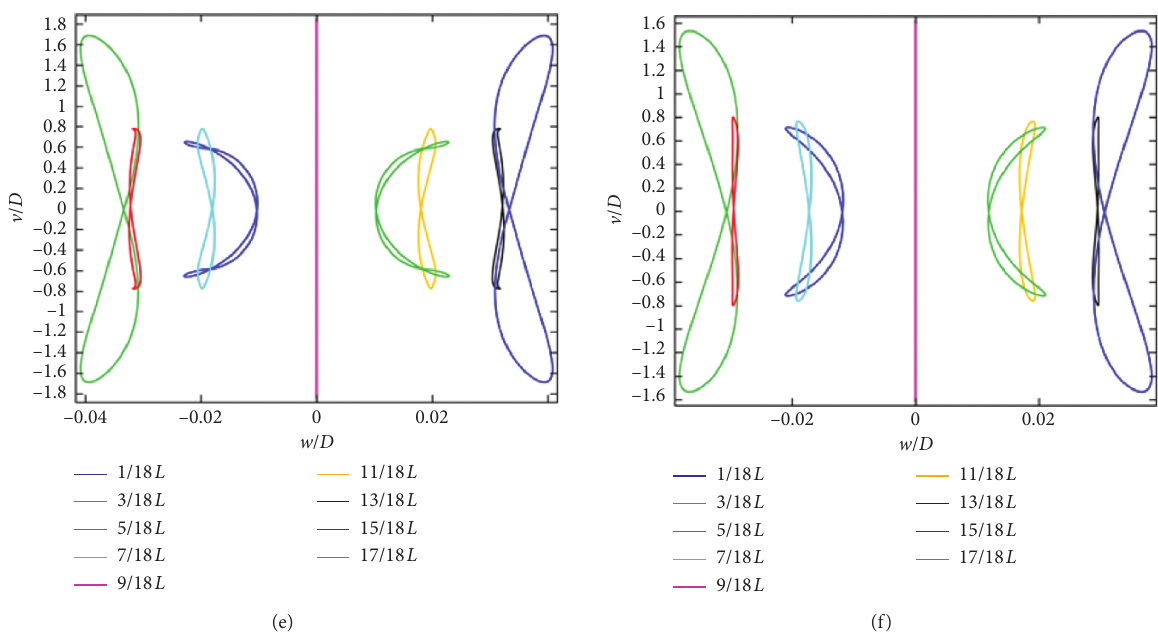
Figure 7: The displacement trajectories of the marine riser at different viscoelastic coefficients in the x - y plane with (a) a � 0.001 and (b) a � 0.11, in the x - z plane with (c) a � 0.001 and (d) a � 0.11, and in the y - z plane with (e) a � 0.001 and (f) a �